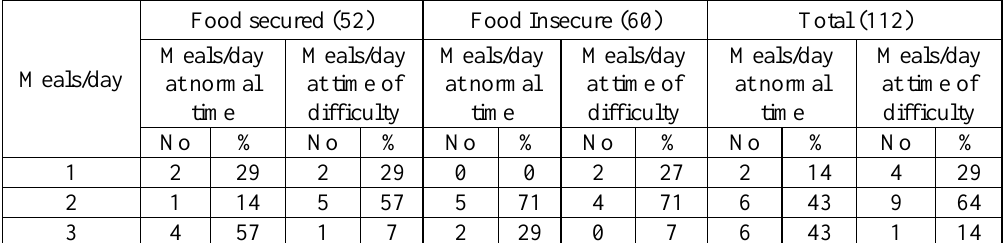
Table 10. Number of meals per day for elderly above the age of 64 at deficit time